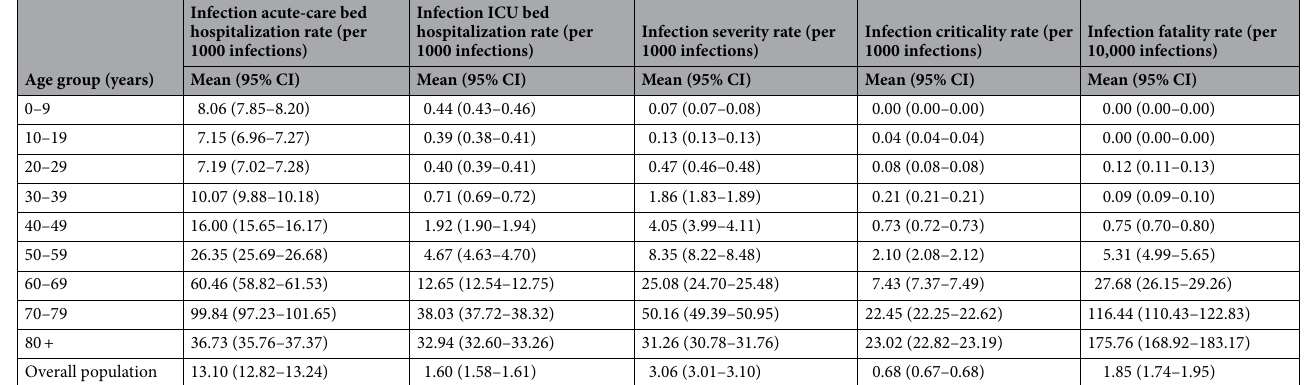
Table 2. Estimated mean and 95% credible interval (CI) of the age-specific infection acute-care and ICU bed hospitalization rates, infection severity and criticality rates, and infection fatality rate. Classification of infection severity and criticality was per WHO infection severity classification 11 .